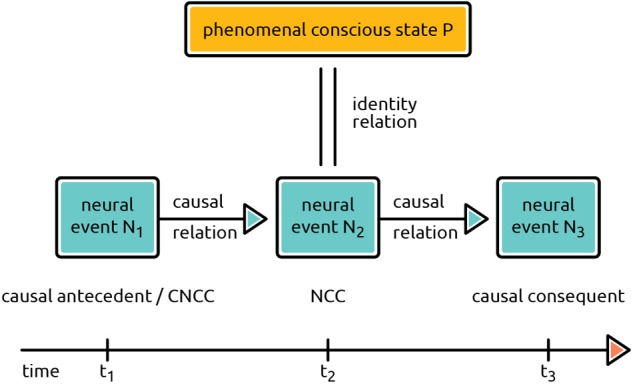
Horizontal and vertical NCCs. The diagram distinguishes between horizontal and vertical relations and isolates the real NCC – neural event N2 in the diagram. It is this event N2 that is to be identified with phenomenal conscious state P. The diagram is based on Hohwy and Bayne (2015, p. 156); modified.